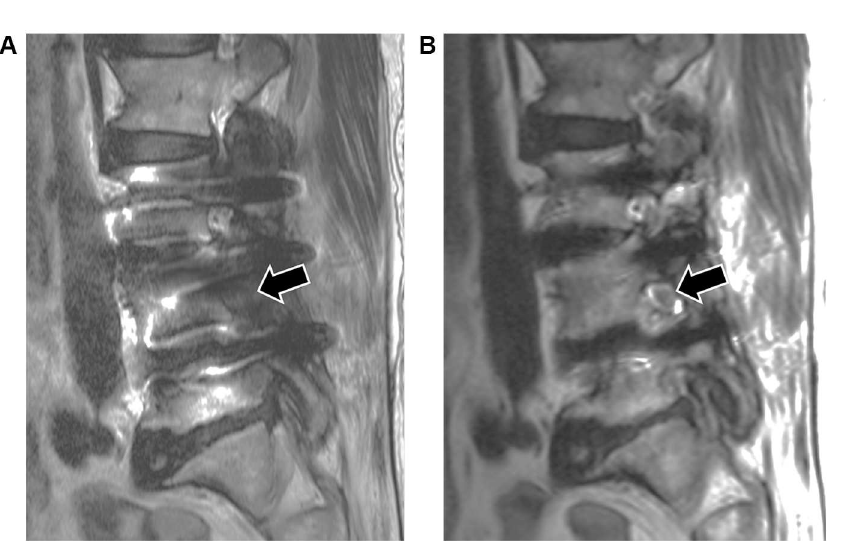
Fig 3. Visibility score of neural foramen and diagnostic confidence of neural foraminal stenosis in sagittal images. These two sagittal images are obtainedfrom a 75 year old female who underwent inter- body fusion at L3-4 and L4-5 and posterior instrumentation at L3-L5 level due to spinal stenosis. The time interval between surgery and the spine MRI was 2 years and 6 months. (a) Sagittal Fast spin echo T2 -weightedimage shows grade 0 (observer 1) and 0 (observer 2) of visibility of neural foramen at the left L4-5 (arrow). (b) Sagittal FSE-SEMAC T2- weightedimage shows grade 3 (observer 1) and 2 (observer 2) of visibility of neural foramen at the same level (arrow). After applicationof FSE-SEMAC sequence, diagnostic confidence level of neural foraminal stenosis was changedfrom grade 3 (inconclusive) to grade 1 (definitely absent) in both